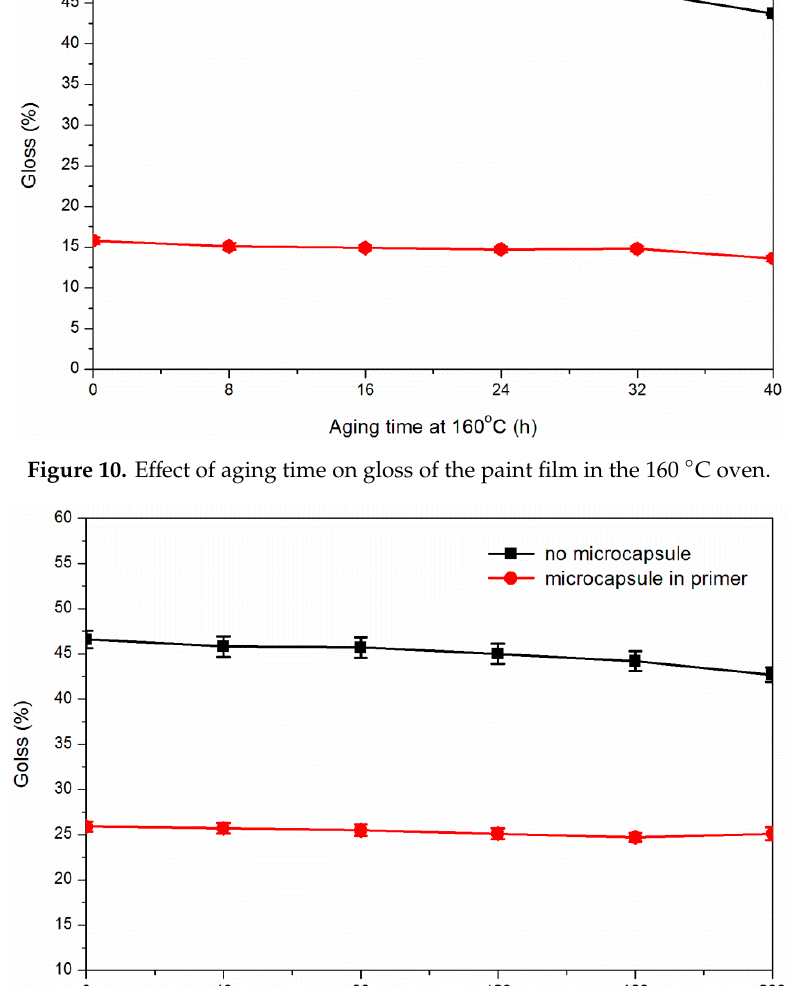
Figure 11. Effect of aging time on gloss of the paint film in the ZN ultraviolet weather resistance test.